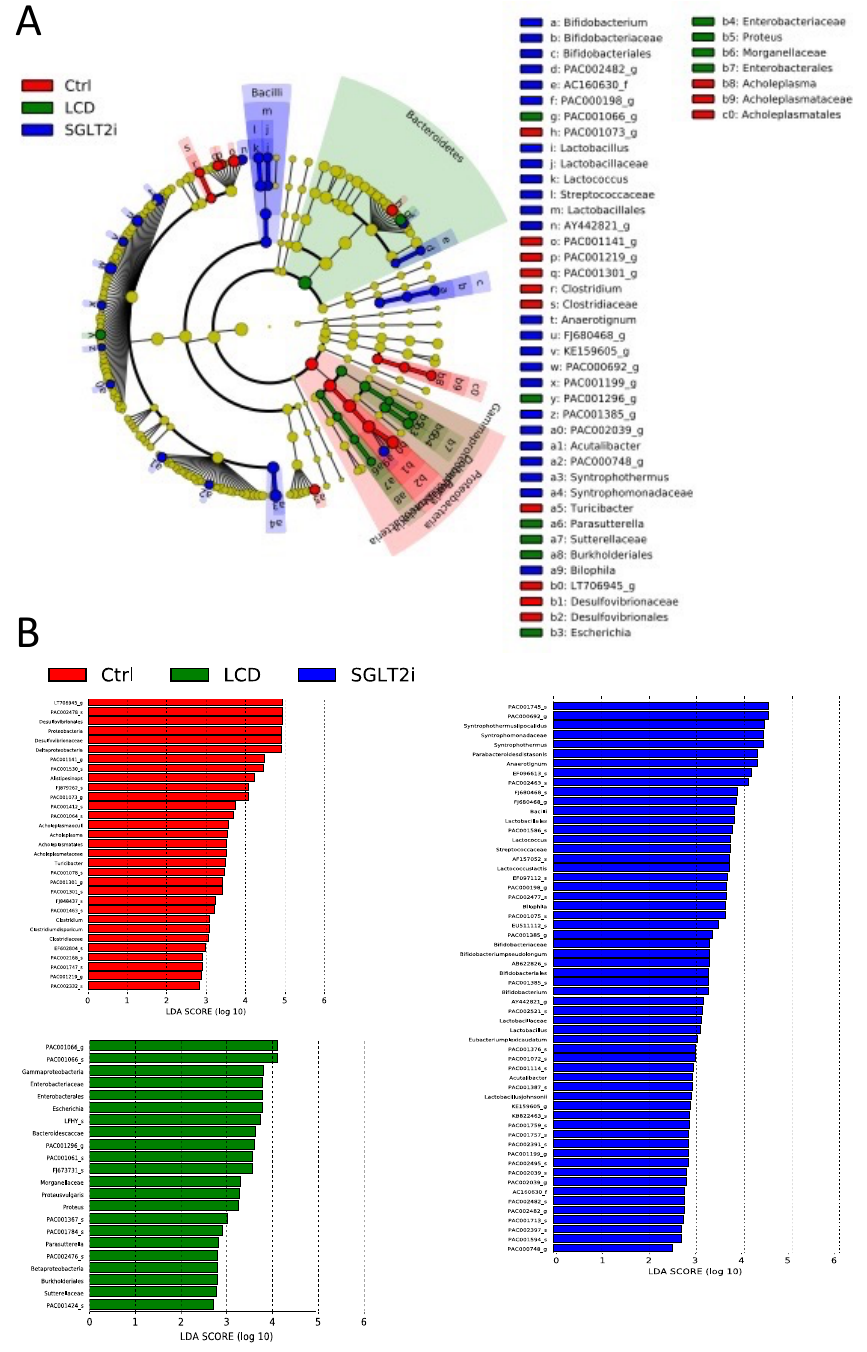
Figure 6. The composition of gut microbiota analyzed using shotgun metagenome analyses. ( A ) LEfSe was used to identify the taxa with the greatest differences in abundance between the gut microbiota of Ctrl, LCD, and SGLT2i groups (n = 3). Ctrl (Red); LCD (Green); SGLT2i (Blue). The brightness of each dot is proportional to the effect size. Only taxa with a significant LDA threshold value > 2 are demonstrated. ( B ) LDA scores of gut microbiota of Ctrl (Red), LCD (Green), and SGLT2i (Blue) groups.